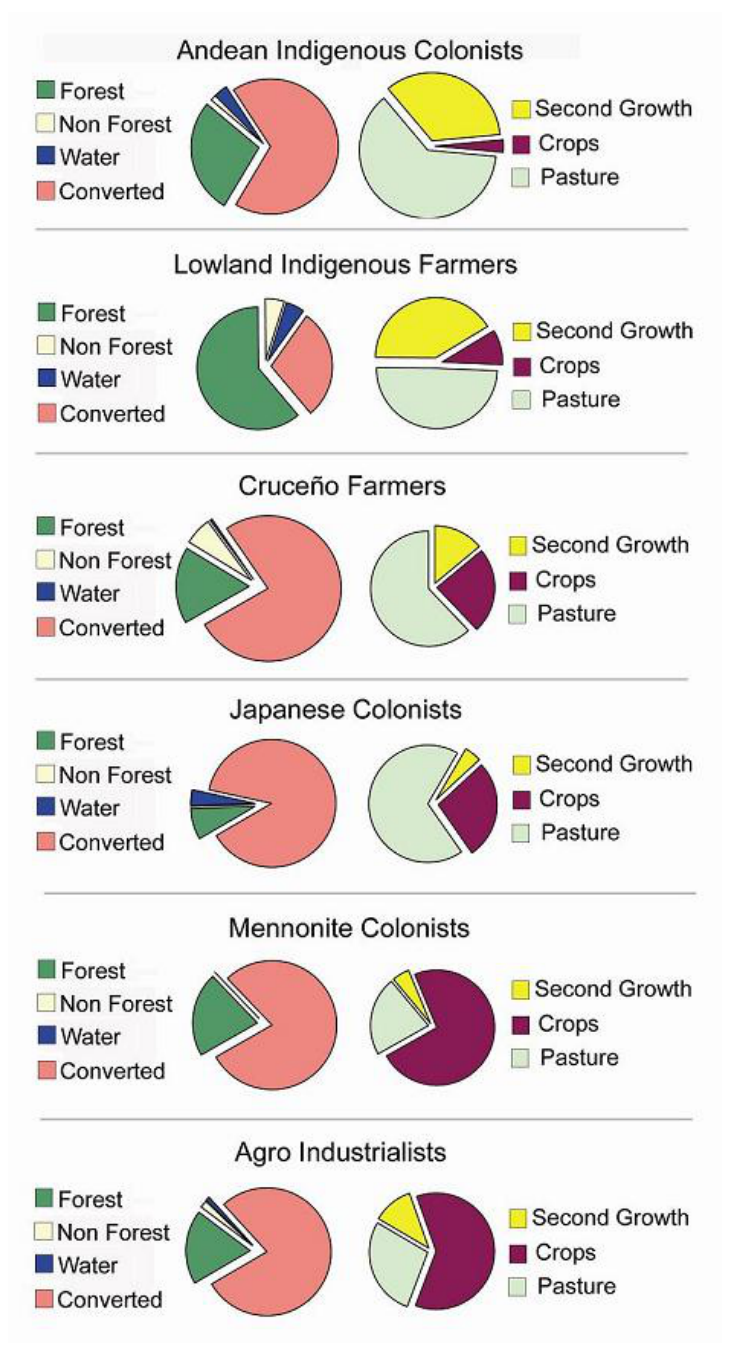
Fig. 5. Land-use intensity for six social and economic groups as determined from a random sample of video images captured during a validation flight. The land-use categories in the right columns are nested within the converted category in the left